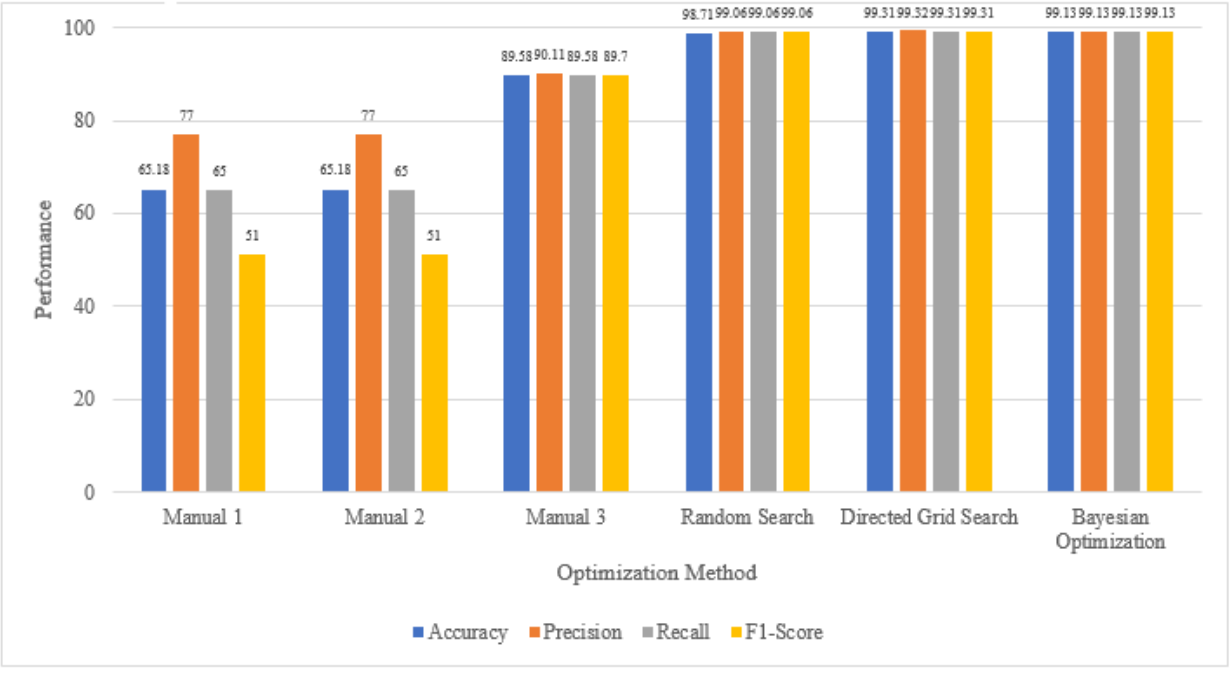
Figure 6. Performance comparison of hardcoded model selection and exhaustive hyper-parameter optimization methods implemented [32].